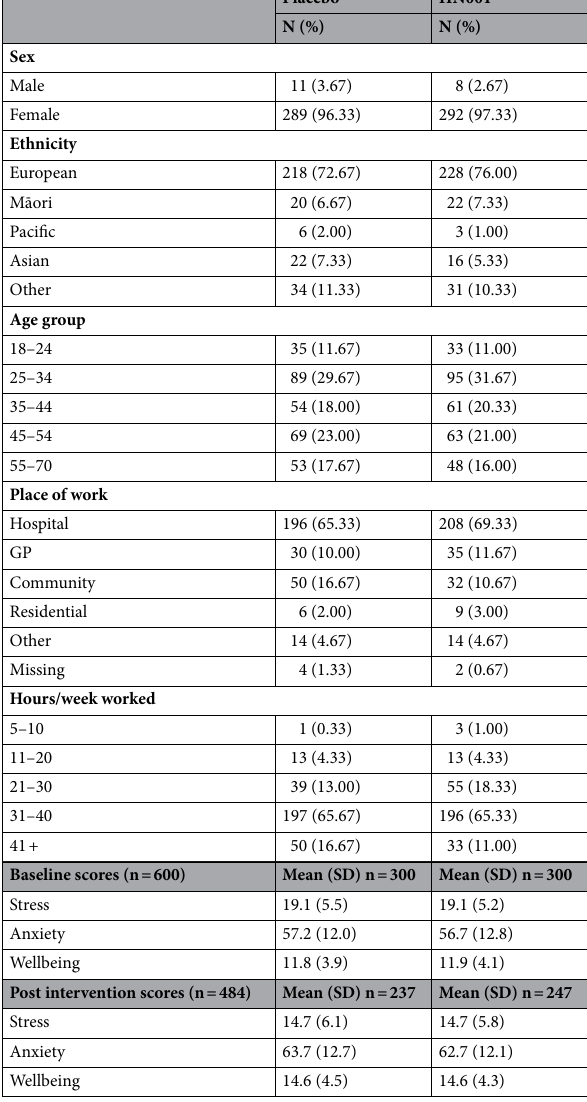
Table 1. Sample characteristics for the probiotic and placebo groups.